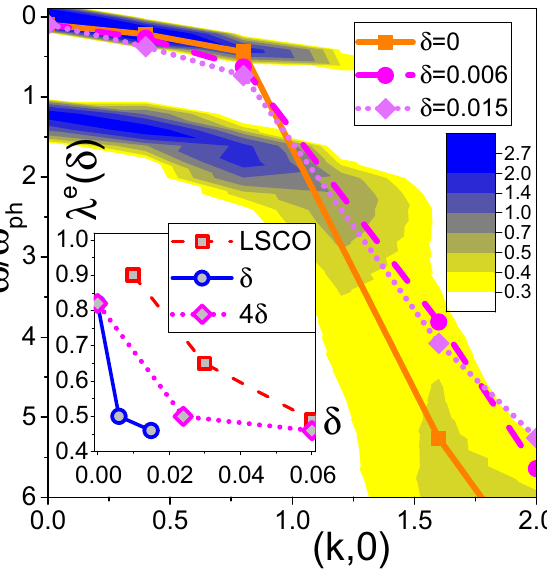
4 with blue/yellow color used for 3.8 10 − = × 0.006 (circles connected by the dashed ≈ 4 ), m 16 ( δ 3.8 10 7 − = = × =